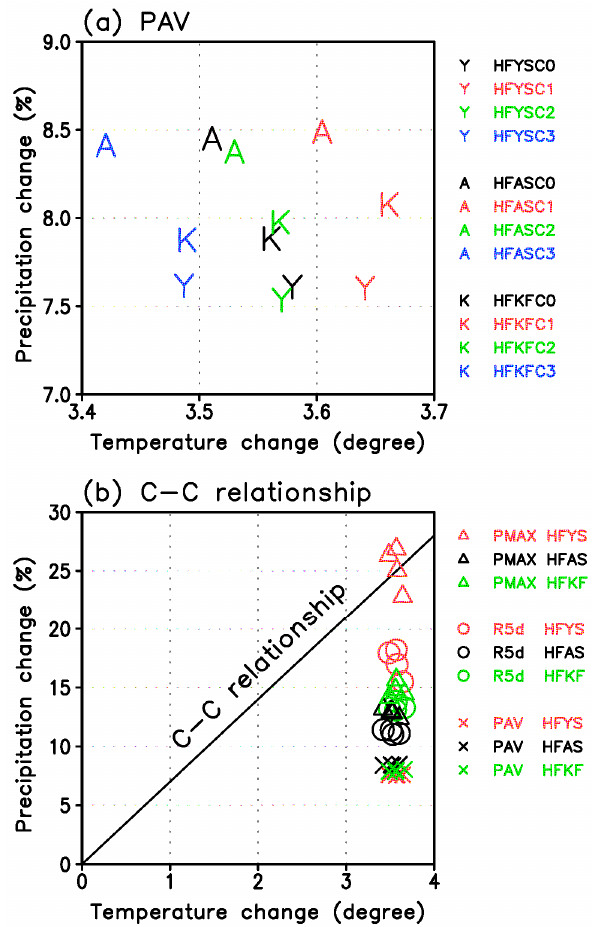
Figure 11. Dependence of precipitation change (%) on global average annual mean surface temperature change (°C). ( a ) Dependence of PAV changes on the cumulus convection scheme and SST. Characters Y, A and K mean the YS, AS and KF schemes, respectively. Black, red, green and blue colors mean SST cluster C0, C1, C2 and C3, respectively. ( b ) Dependence of precipitation change on different indices. The black slanted line denotes the rate of precipitation increase (7.5%/°C) expected from the Clausius–Clapeyron relationship. The X mark, circle and triangle mean PAV, R5d and PMAX, respectively. Red, black and green colors mean the YS, AS and KF schemes, respectively.